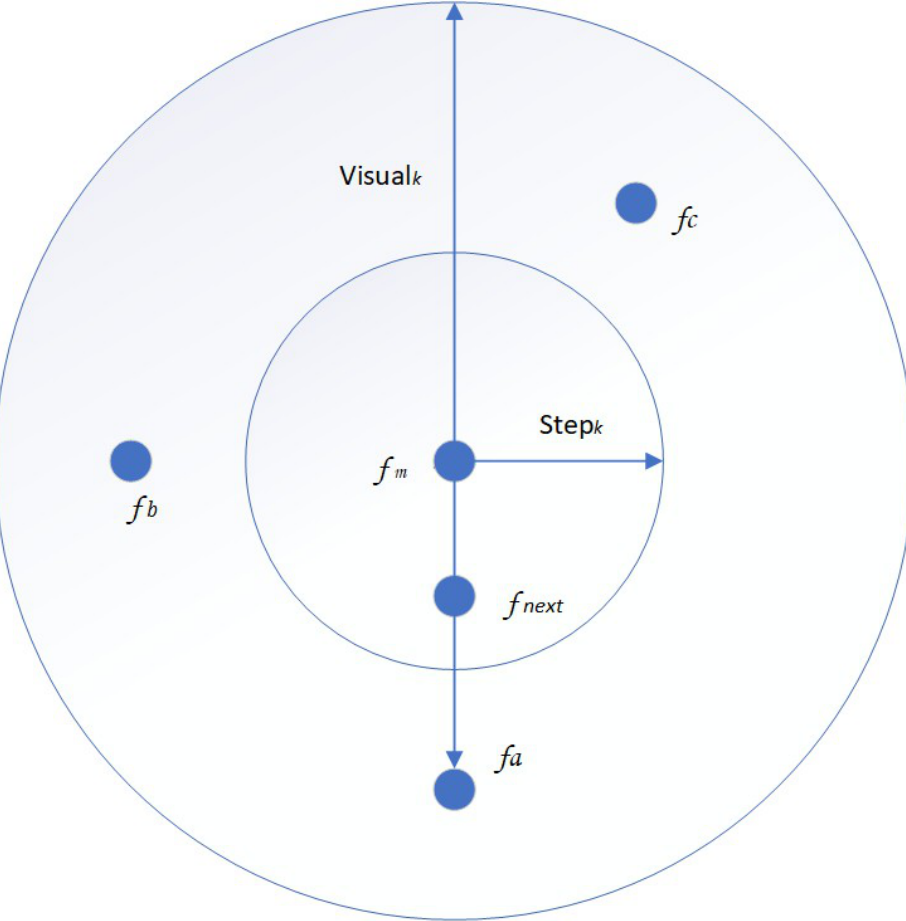
Figure 4. Vision field and step length of artificial